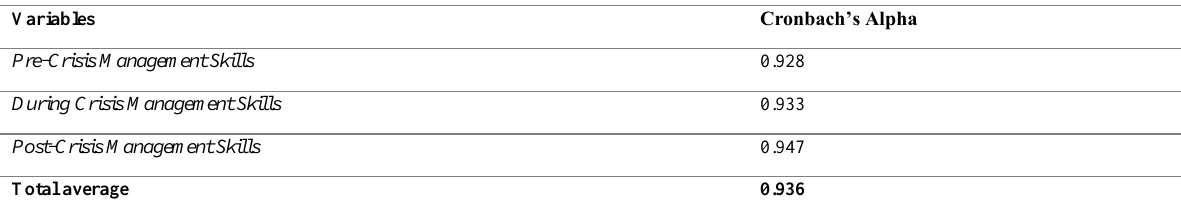
Table 3: Reliability test